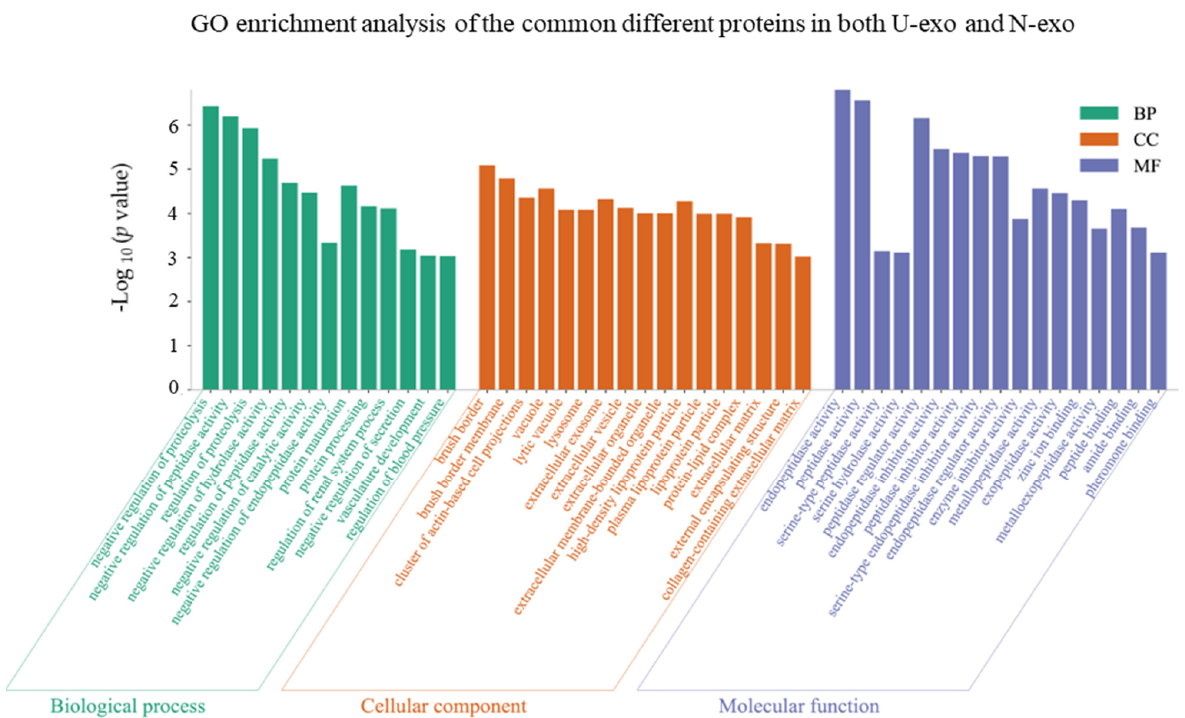
Figure 5. GO enrichment analysis of the common different proteins identified in both U-exo and N-exo. U-exo: urine exosomes. N-exo: neuron-derived exosomes.